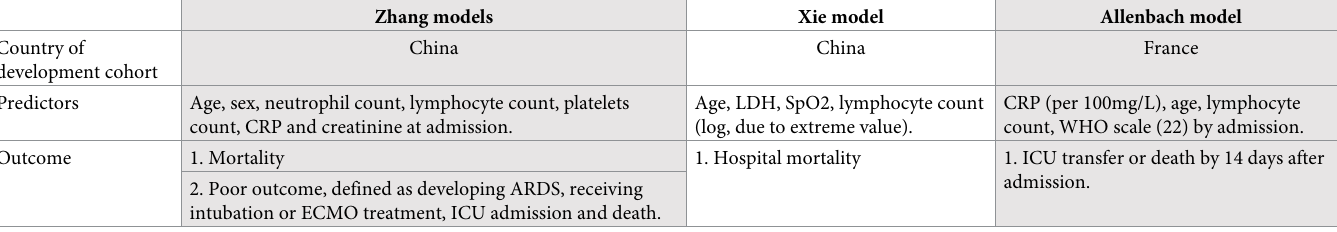
Table 1. Predictors and outcomes in the four prediction